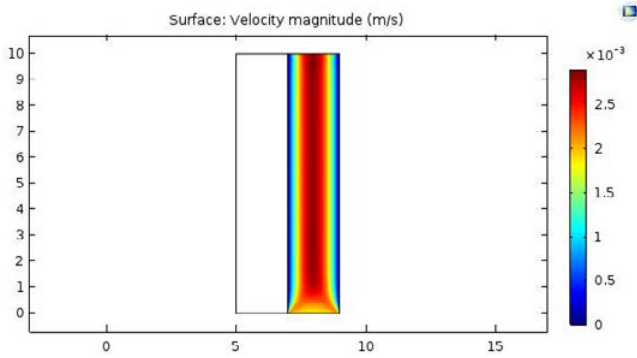
Fig. 11: Velocity distribution in the feed phase at 0.5 l/min feed flow rate